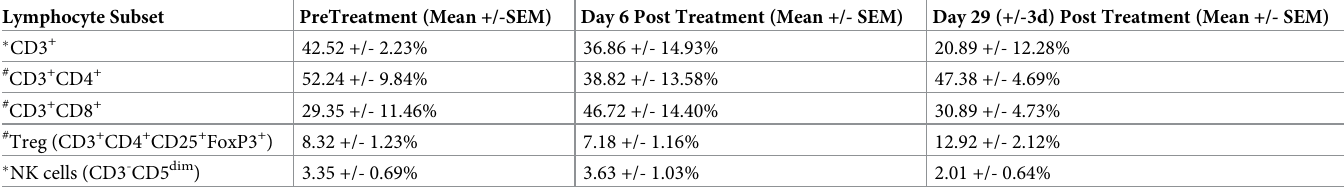
Table 3. Composition of circulating T cells.